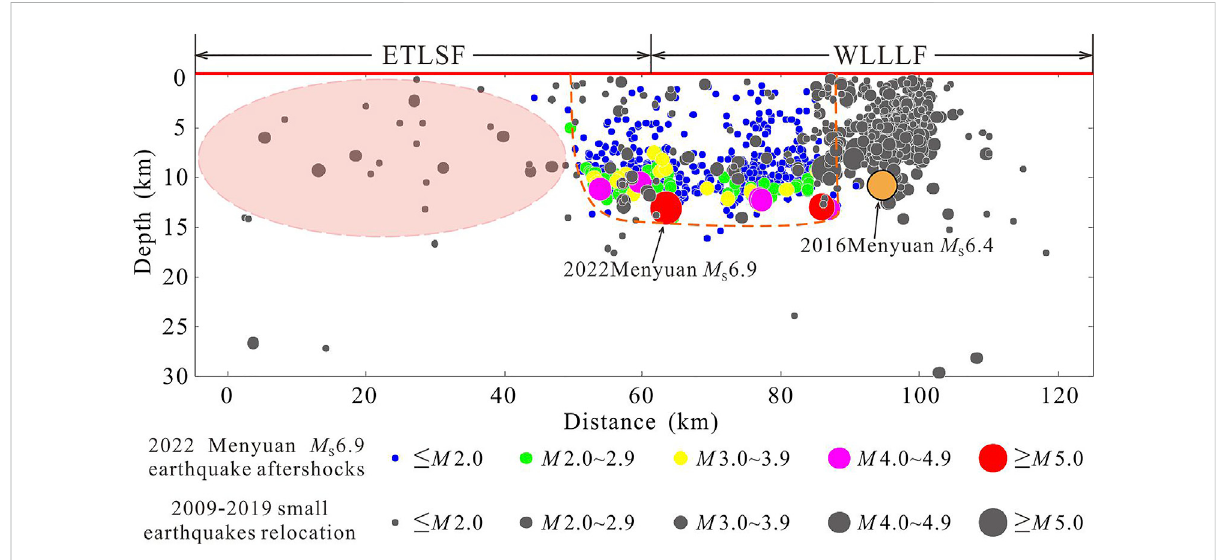
FIGURE 9 Pro fi le of the 2009 – 2019 small earthquakes relocation (colored circles) and 2022 Menyuan M S 6.9 earthquake aftershocks (gray circles). Location of pro fi le is shown in Figure 7. The pink ellipse corresponds to area of high risk for future earthquake. ETLSF: eastern segment of the Tuolaishan fault; WLLLF: western segment of the Lenglongling